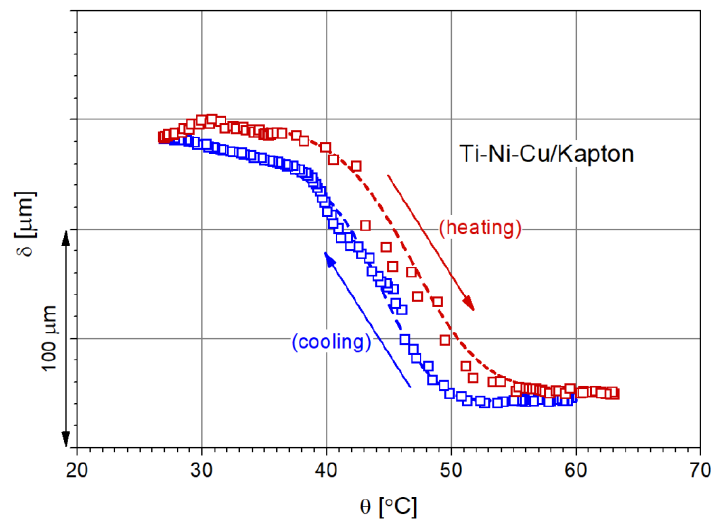
Figure 12. Deflection vs. temperature of the free end of a bimorph cantilever with Ti-Ni-Cu film deposited at 550 °C on Kapton (arrows indicate heating and cooling, respectively).